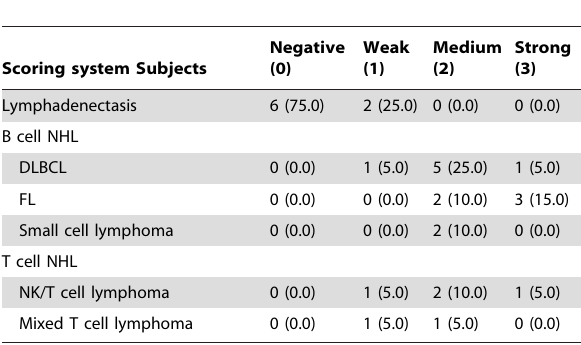
Table 2. Grading system based on the intensity and extent of LDH5 cytoplasmic and nuclear